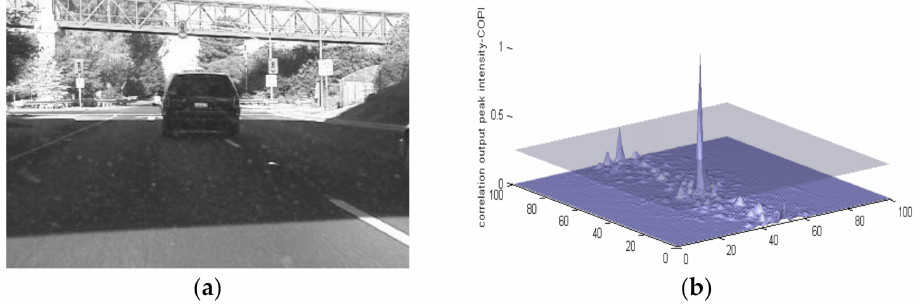
Figure 6. ( a ) An occluded grayscale vehicle (Data Set-4) and ( b ) MACH results.